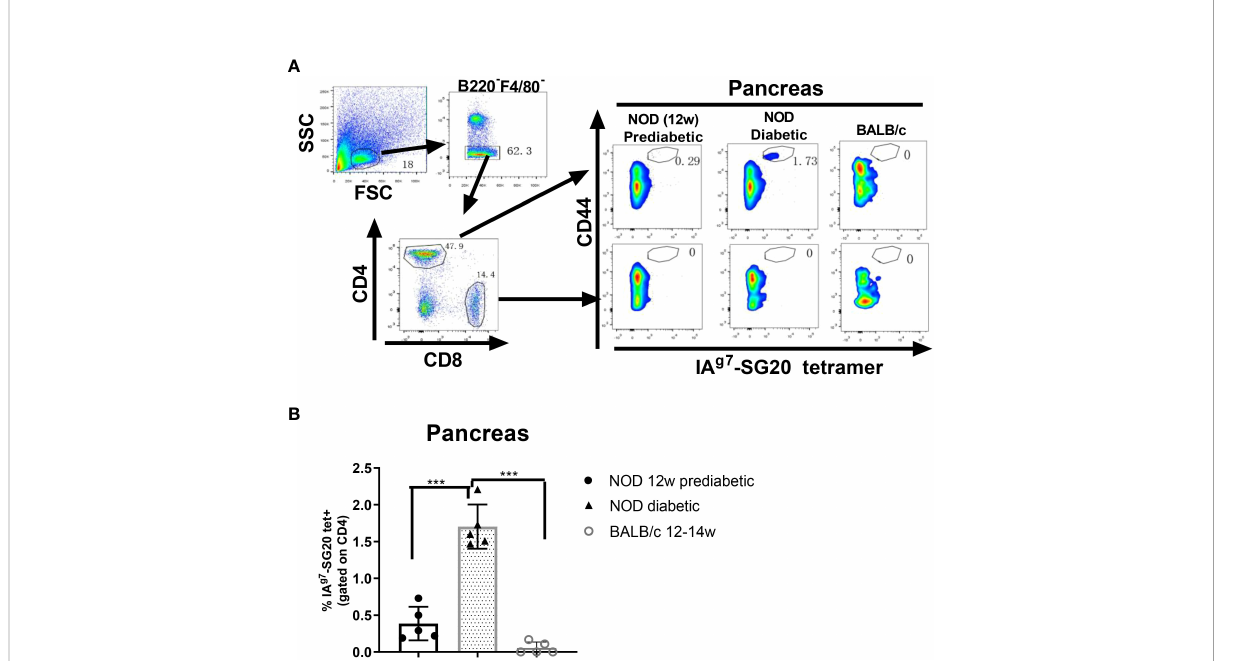
FIGURE 4 IA g7 -SG20 tet + cells were present in the pancreas of prediabetic and diabetic NOD mice. Single-cell suspensions were prepared from the whole pancreas of each prediabetic (n=5; 12 weeks) or diabetic NOD mice (n=5; 12-23 weeks). Female BALB/c mice (n=5; 12-14 weeks) were used as the negative control. The cells were stained with IA g7 -SG20 tetramers, anti-B220, anti-F4/80, anti-CD44, anti-CD4, and anti-CD8. For tetramer analysis, cells were pregated on live, B220 − , F4/80 − , CD8 − , CD4 + , and CD44 high cells. (A) Representative scatter diagram of IA g7 -SG20 tet + CD44 + cells in different groups. (B) The percentages of IAg7-SG20 tet+CD44+ in CD4+ T cells of each group. Each symbol represented an individual mouse. Results are the means ± SEM. * P < 0.05, ** P < 0.01. *** P <